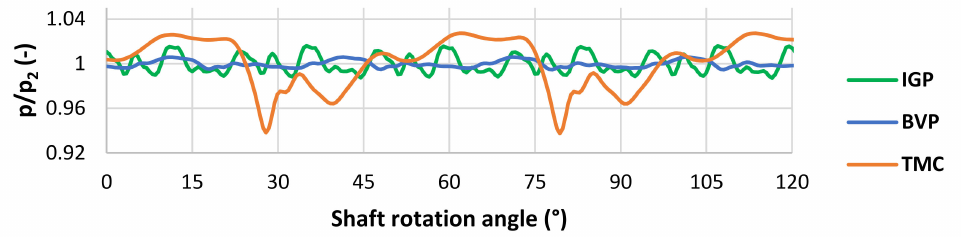
Figure 20. Comparison of the CFD data for the delivery port pressure ripple at 22.5 bar pressure load, 20 ◦ C oil temperature and 2000 rpm.